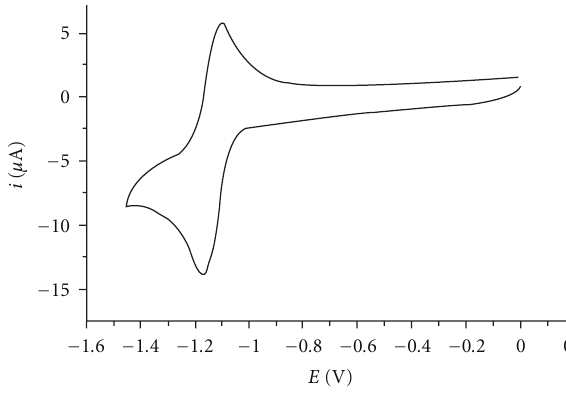
Figure 1: Reduction voltammogram of aclonifen.